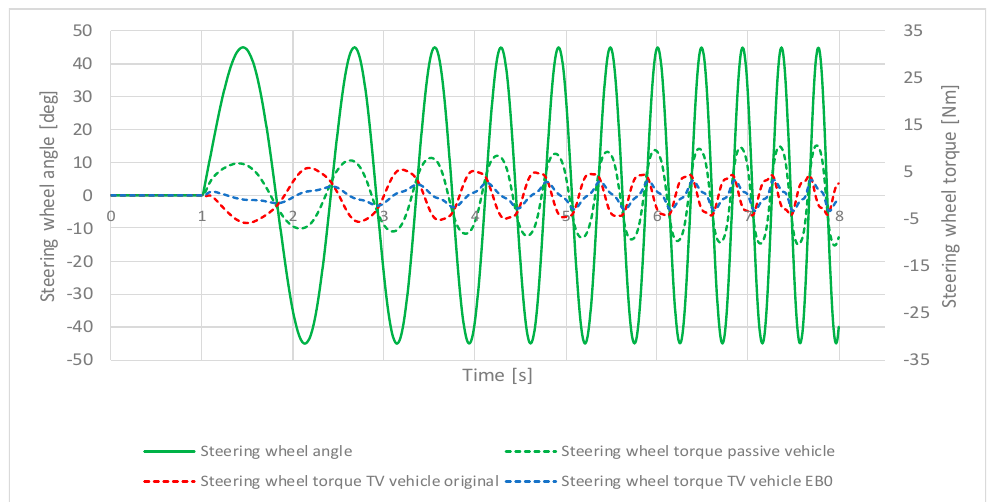
Figure 15. The EB0 sine steer (blue line) compared with TV original (red) and passive vehicle (green).